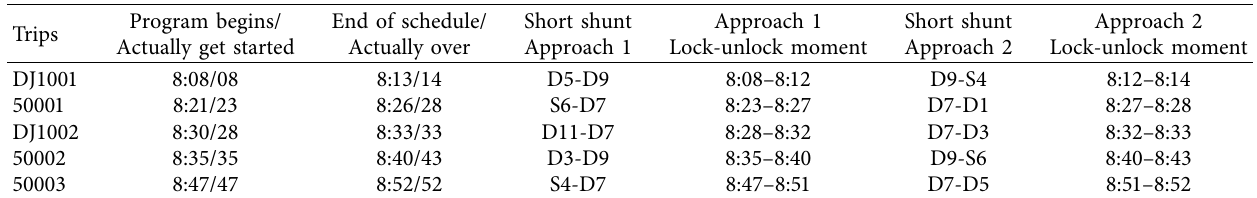
Table 3: Results of solving the shunting operation plan.